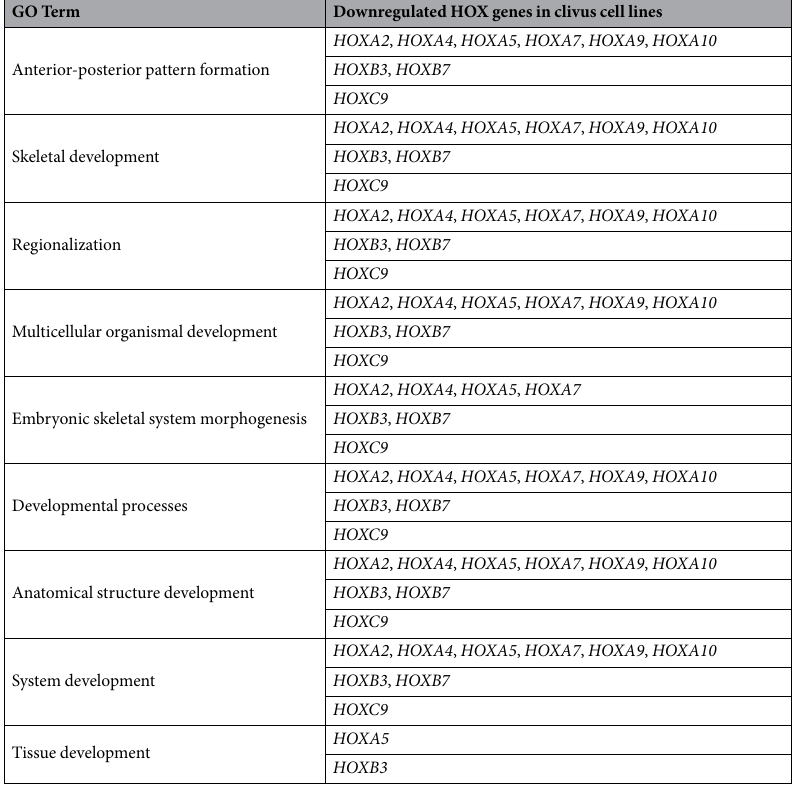
Table 2. HOX genes down regulated in clivus chordoma cell lines compared to sacrum chordoma cell lines and the related gene ontology (GO)